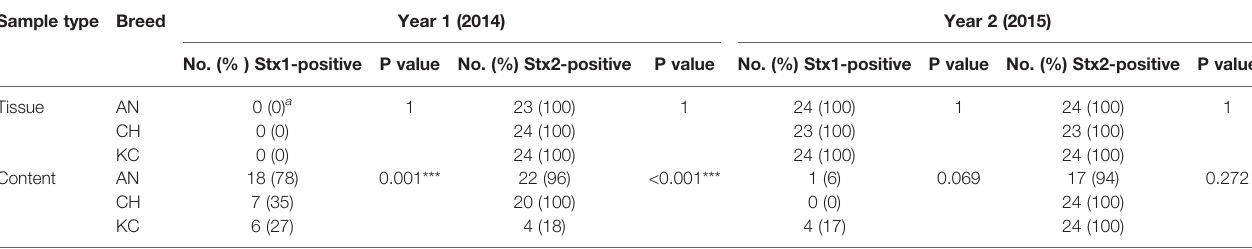
TABLE 2 | The prevalence analysis of stx1 and stx2 for samples collected from the rectal tissue and content in 2014 and 2015. Sample type